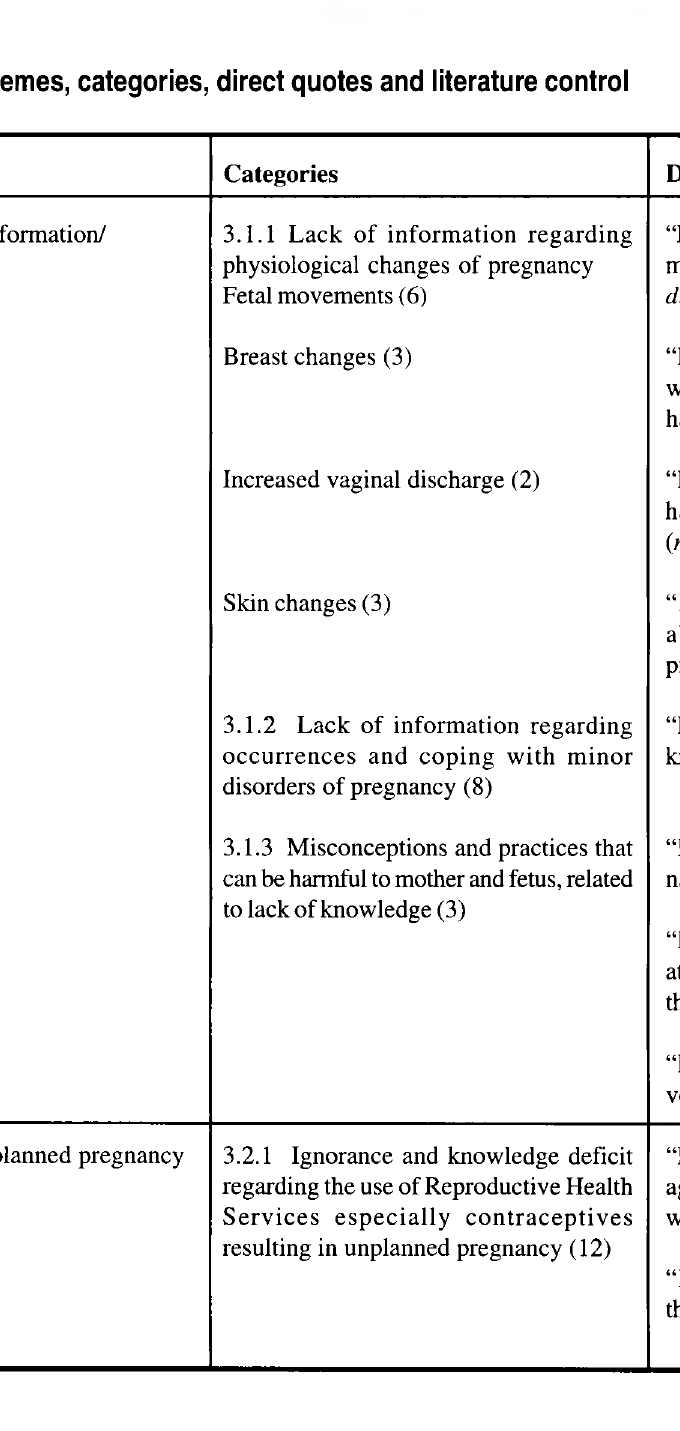
Table 1: Main themes, categories, direct quotes and literature